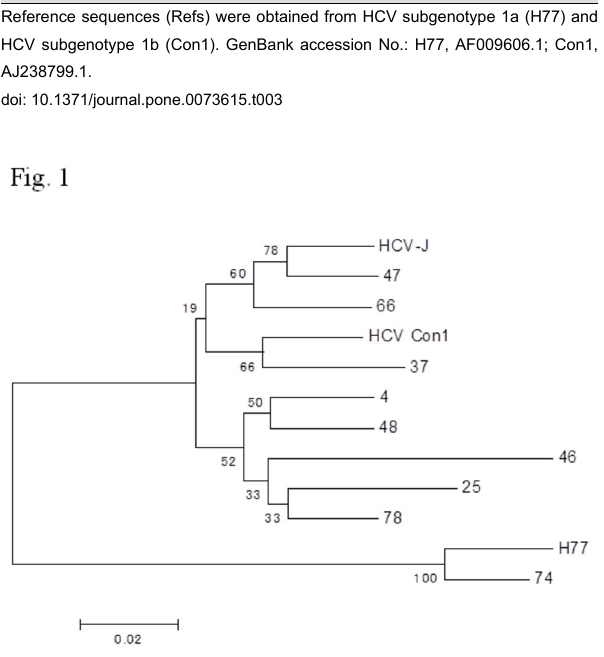
Figure 1. Phylogenetic tree analysis by the Neighbor- Joining (NJ)